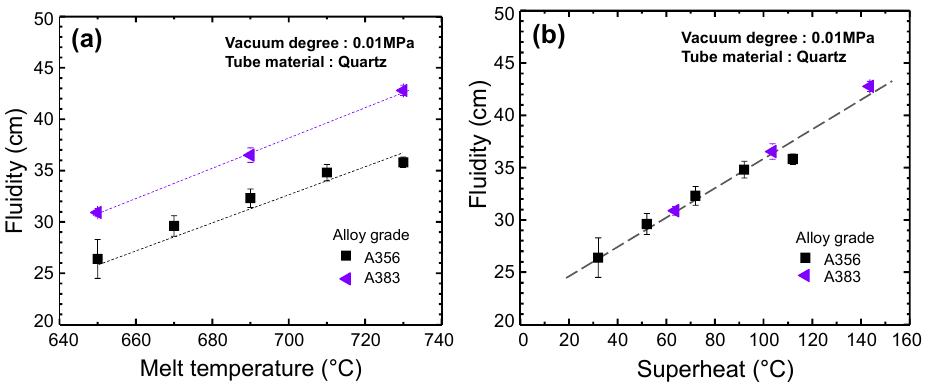
Figure 4. The effect of ( a ) melt temperature and ( b ) superheat on the fluidity of A356 and A383